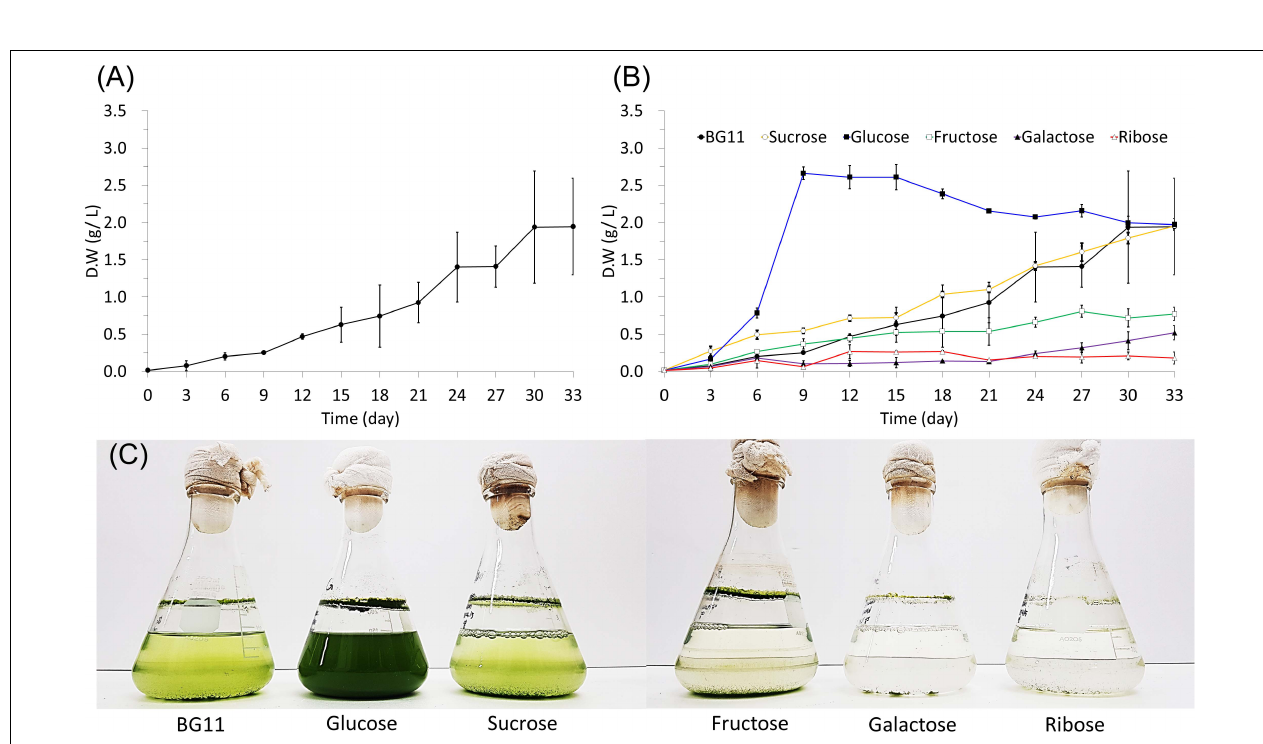
FIGURE 3 | Growth of B. sudetica KNUA107 under photoautotrophic (BG11) (A) and mixotrophic (sucrose, glucose, fructose, galactose, and ribose) (B) conditions measured by dry weight. Visible changes in KNUA107 cultures with each culture condition at day 30 (C) .